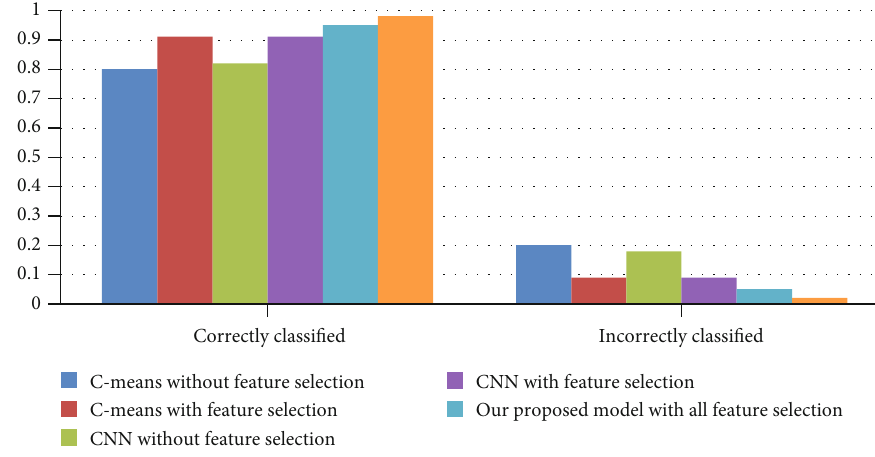
Figure 6: Correctly classi fi ed versus incorrectly classi fi ed